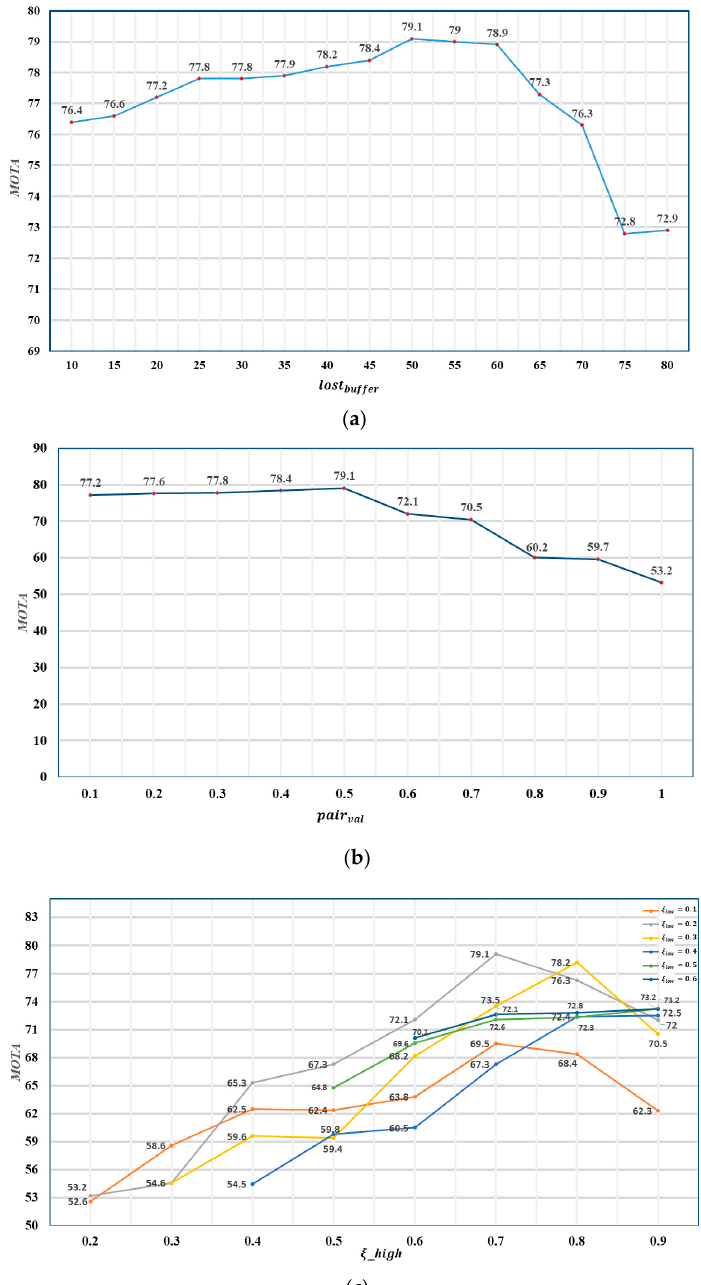
Figure 4. Tracking performance of FSTA with different hyperparameters. ( a ) Tracking performance with different lost buf fer ; ( b ) tracking performance with different pair val ; ( c ) tracking performance with different ξ high under different ξ low